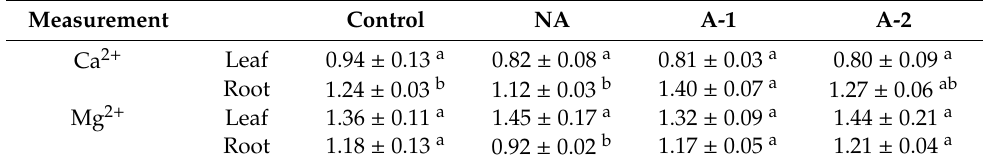
Table 1. E ff ects of 10-days sodic-alkalinity with 100 mM NaHCO 3 on Ca 2 + and Mg 2 + concentrations in the leaf and root tissues of pre-acclimated rye. Rye plants were pre-acclimated by 0 mM NaHCO 3 (NA) and 1 and 2 mM NaHCO 3 (A-1, A-2) for 10 days. Control plants were consistently irrigated by nutrient